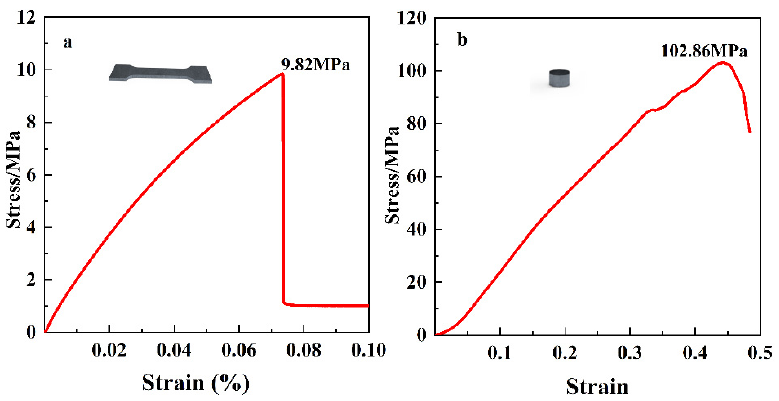
Figure 9. Specimen tensile and compressive strength curves: ( a ) stress-strain curve of tensile strength; ( b ) stress-strain curve of compressive strength.